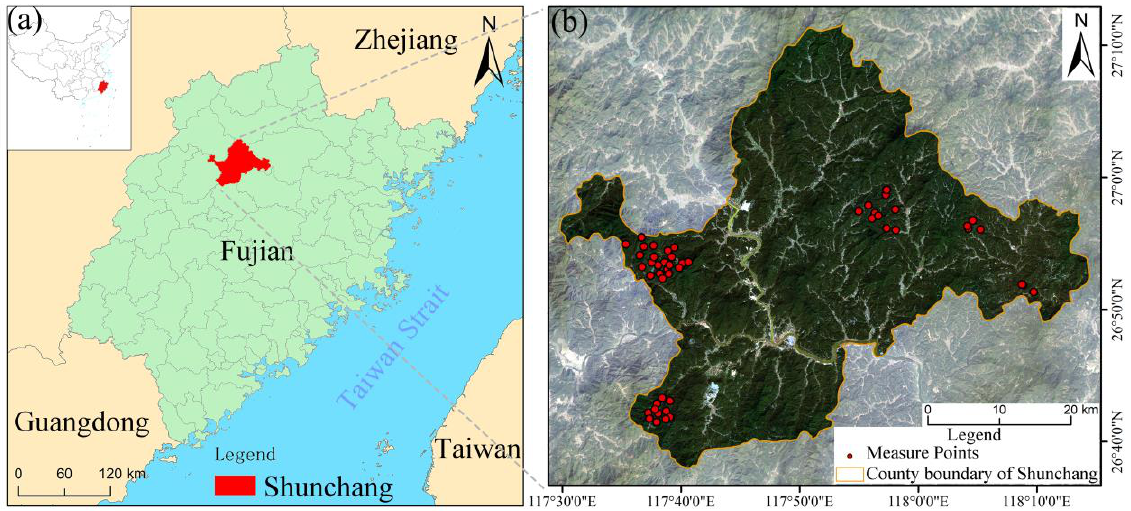
Figure 1. Study site: ( a ) location of the study area in Shunchang County; ( b ) remote sensing images and locations of sampling sites in Shunchang County.